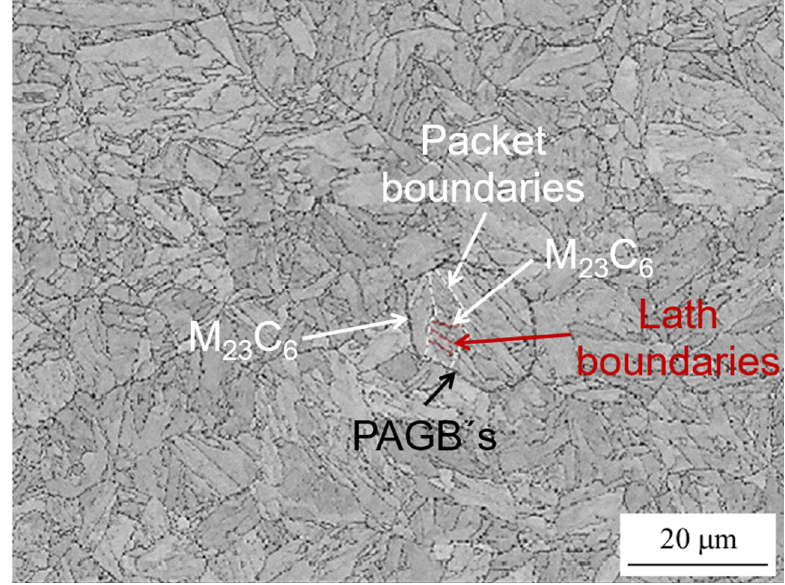
Figure 1. The characteristic microstructure of tempered ferritic-martensitic steel P91 [5]. PAGB, prior austenite grain boundaries.